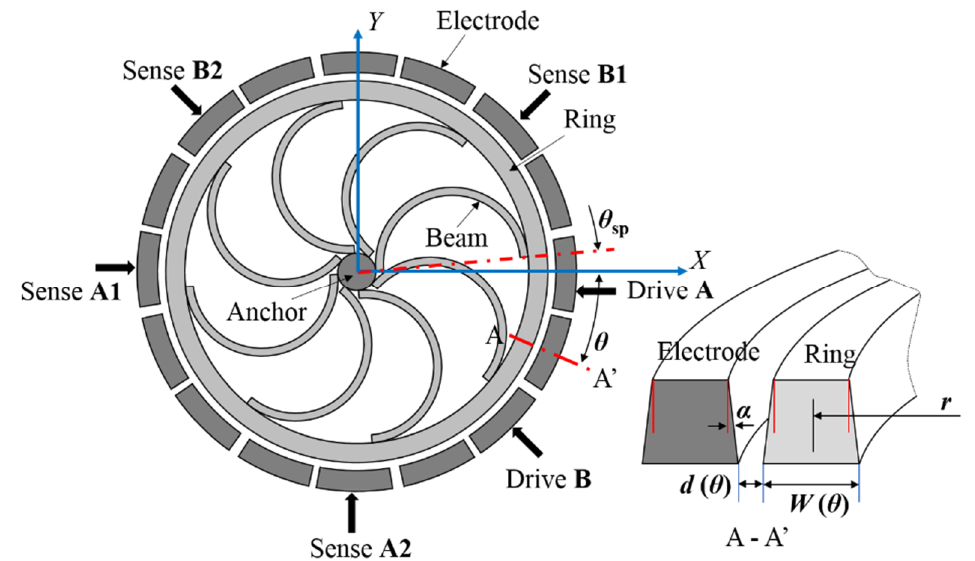
Figure 2. Schematic view of a ring resonator and a section of the ring and the surrounding electrode locating at θ .